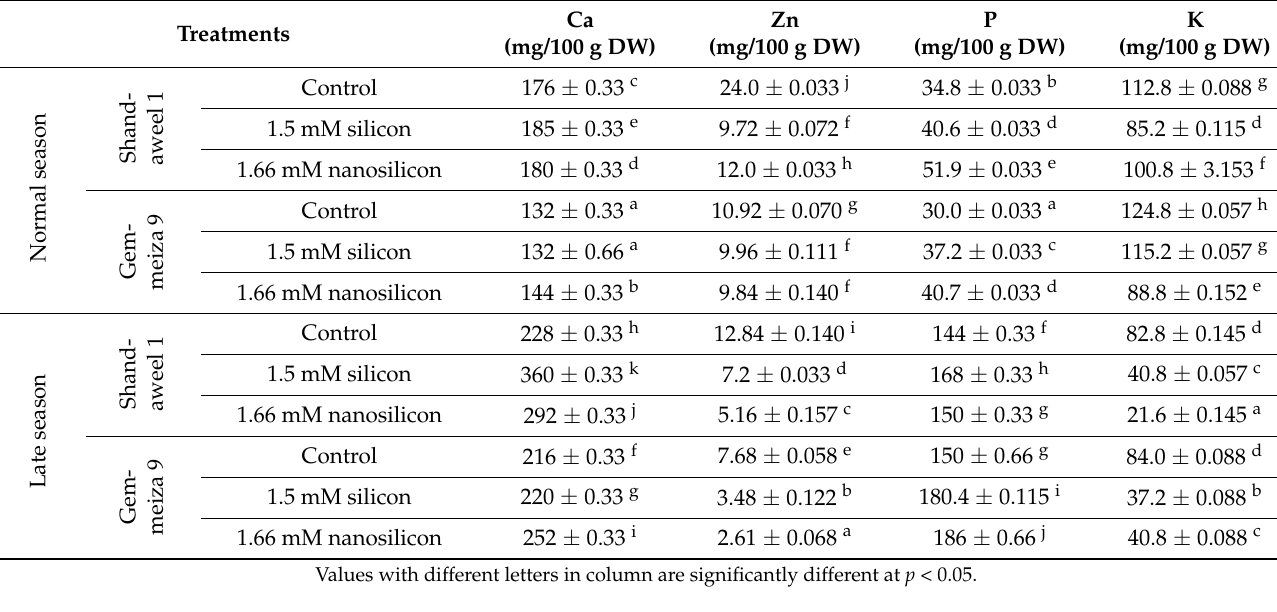
Table 10. Effects of silicon and nanosilicon on calcium (Ca), zinc (Zn), phosphorous (P) and potassium (K) in straw of two wheat cv. Shandaweel 1 and cv. Gemmeiza 9 at normal and late seasons. Each value is the main of three different replicates ± SE.